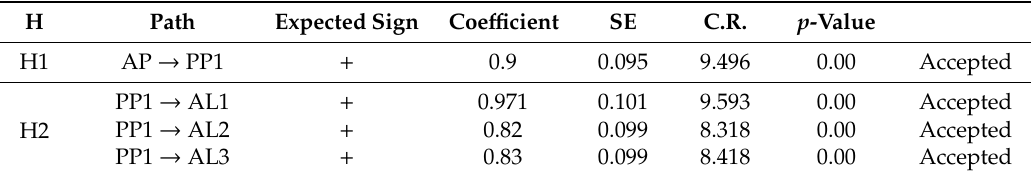
Table 11. Paths through PP1. H—hypothesis.